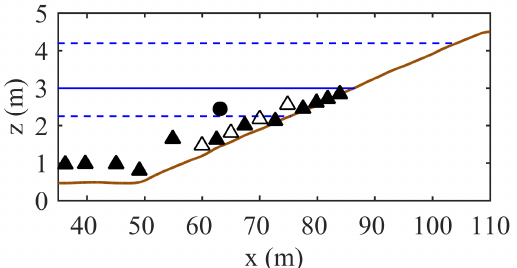
Figure 1. Initial bed elevation z versus cross-shore distance x from the wave paddle (brown line). The blue line is the default still water level h ; the two dashed blue lines s represent the lower and upper h , see Table 1. The 16 triangles represent the locations of s pressure transducers. At the 4 open triangles the pressure transducer was co-located with an electromagnetic or acoustic current meter. The filled circle is the approximate location of the 3D Profiling